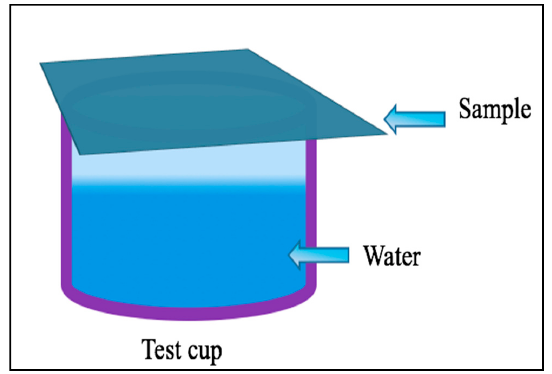
Figure 3. Testing method of water vapor transmission (WVT).